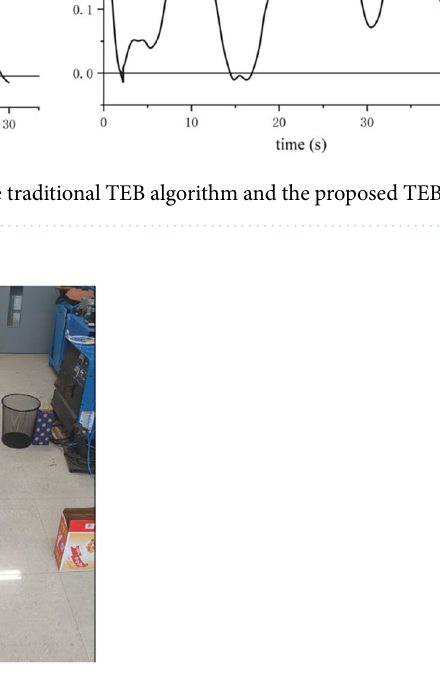
Figure 14. Robot testing